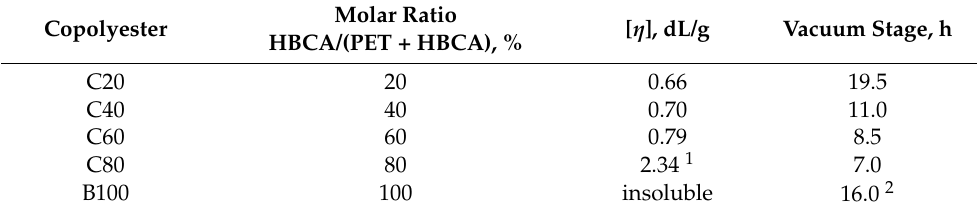
Table 1. Comonomer ratio, synthesis duration, and intrinsic viscosity of the copolyesters C20–C80. Molar Ratio Copolyester [ η ], dL/g Vacuum Stage, h HBCA/(PET + HBCA), % C20